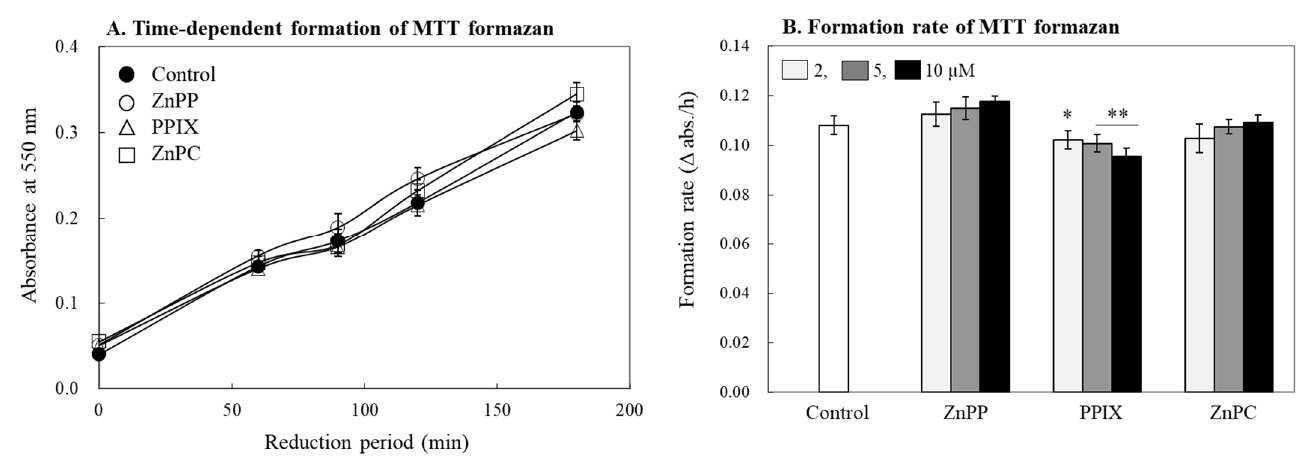
Figure 4. Effects of porphyrin derivatives on the formation of MTT formazan in cells. A same population of INT 407 cells were treated with ZnPP, PPIX, and ZnPC (10 μ M) with MTT reagent simultaneously, and reduction of MTT tetrazolium to formazan in cells was measured at 550 nm during 3 h ( A ). The reduction rates ( Δ abs./h) in the absence or presence of each porphyrin derivatives were also calculated ( B ). Each value represents the mean ± S.D. ( n = 4). *, ** Significantly different from control according to Student’s t ‐ test (*, p < 0.05; **, p < 0.01).